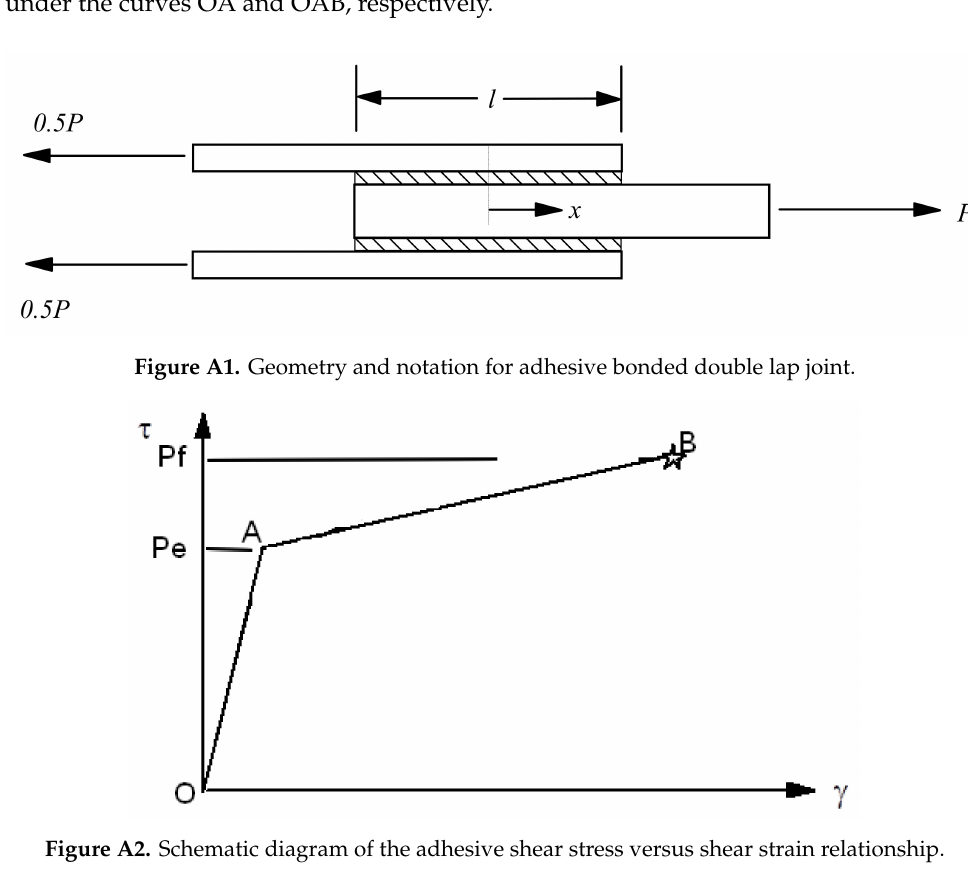
Figure A2. Schematic diagram of the adhesive shear stress versus shear strain